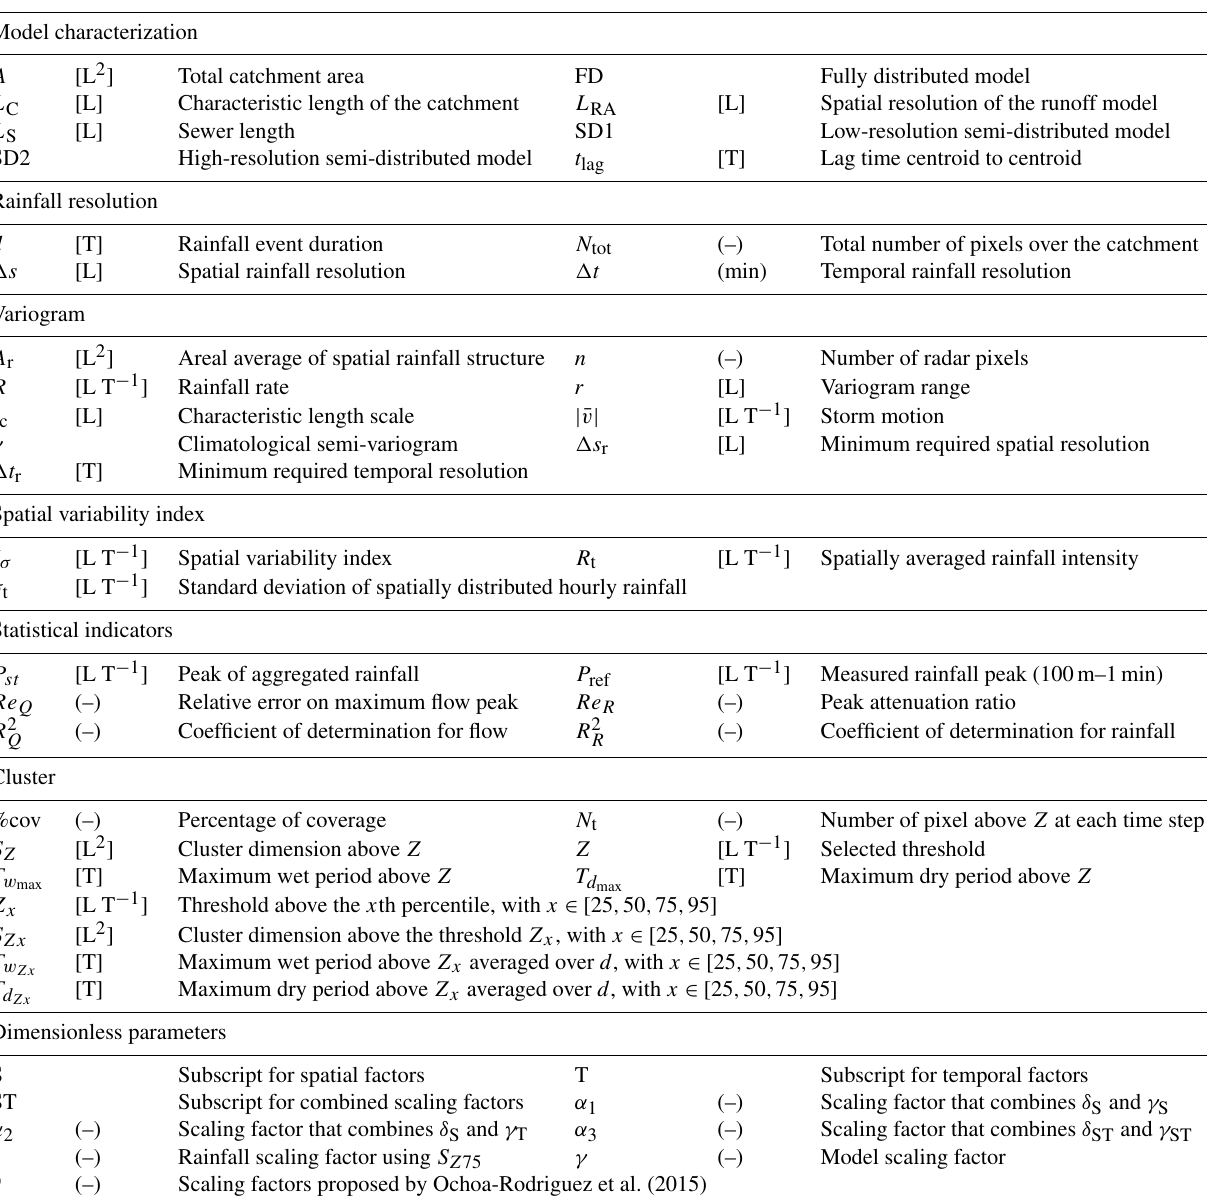
Table 1. List of symbols and abbreviations. Model